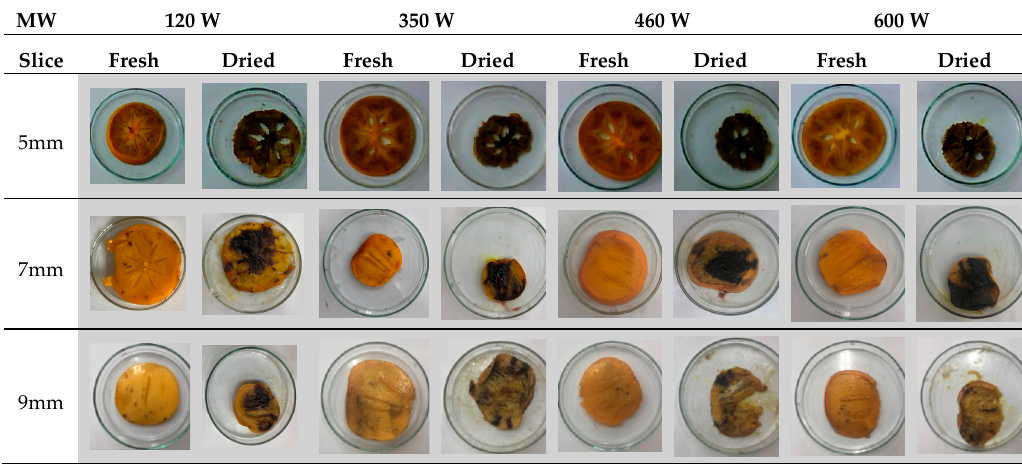
Figure 6. Fresh and dried pictures of persimmon.